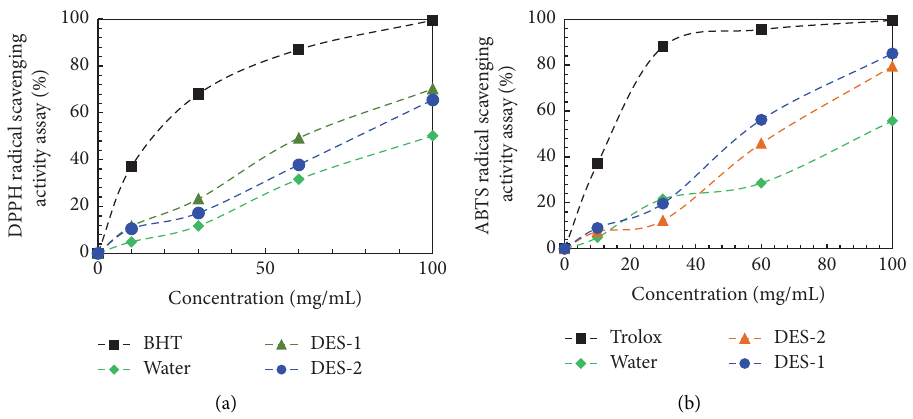
Figure 5: DPPH (a) and ABTS (b) radical scavenging activity of the grape pomace extracts.